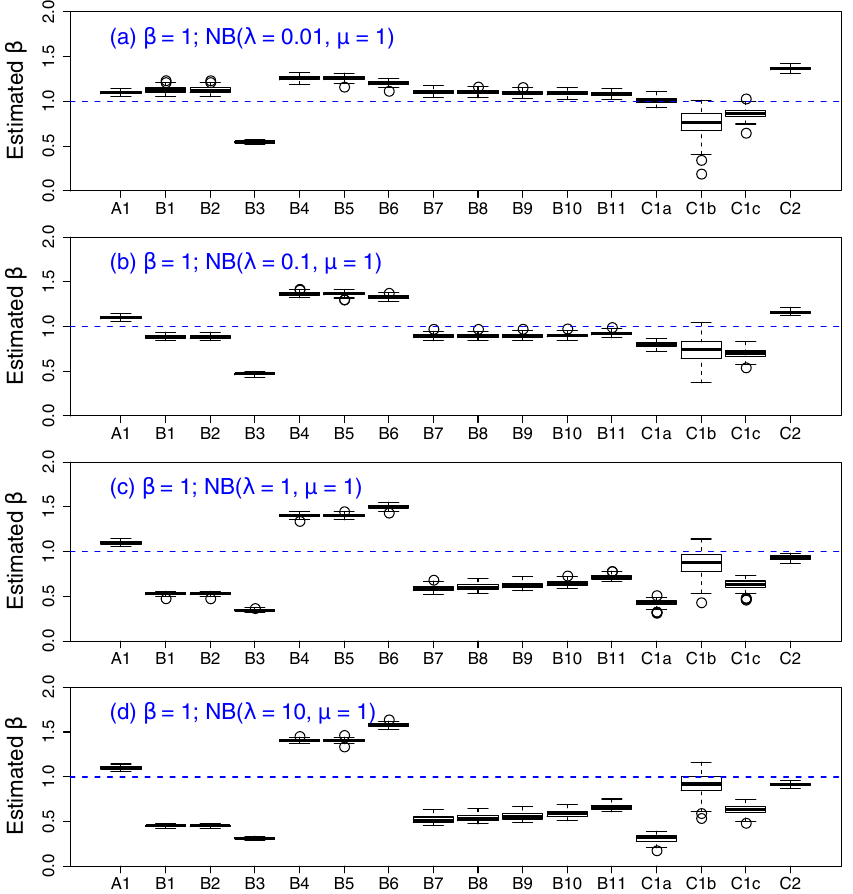
Figure 5. Comparison of bias in estimated spectral slope in irregular data that are simulated with prescribed β = 1 (100 replicates), a series length of 9125, and gap intervals simulated with (a) NB ( λ = 0.01, µ = 1), (b) NB ( λ = 0.1, µ = 1), (c) NB ( λ = 1, µ = 1), and (d) NB ( λ = 10, µ = 1). The blue dashed lines indicate the true β